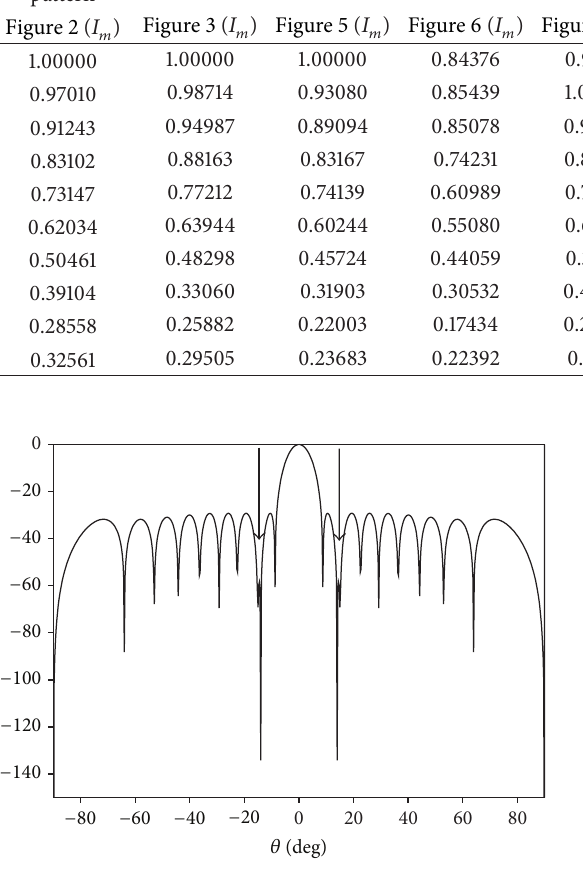
Figure 3: Radiation pattern achieved by controlling the amplitude only with one null at 14 ∘